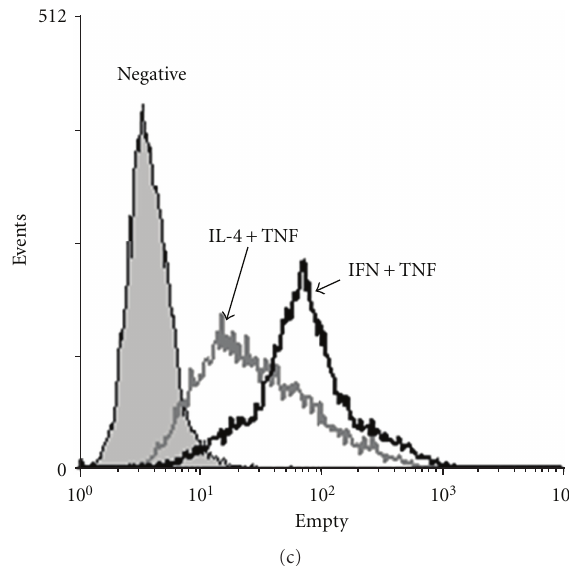
Figure 1: The e ff ect of cytokine treatment on CD40-expression in MTHCs. (a) The FACS results show CD40-positive cells (%) after the 3 cytokine treatments or cotreatments at di ff erent doses. The doses for IFN- γ (IFN), TNF- α (TNF), and IL-4 treatment alone were as labeled. For TNF- α co-treatment with IFN- γ and IL-4, TNF- α dose was 200 units/mL and IFN- γ and IL-4 doses were as labeled. The data were the mean ± SE from 3 separate experiments after 48 hours of treatment. (b) The diagrams show the dot plot analysis of the results from above treatments. Negative: the antibody isotype control. GM: GM-CSF alone. (c) shows the FACS histogram analysis of fluorescent intensity for GM + IL-4 + TNF- α (IL-4 +TNF) and GM + IFN- γ + TNF- α (IFN+TNF) groups in (b). Negative: the antibody isotype